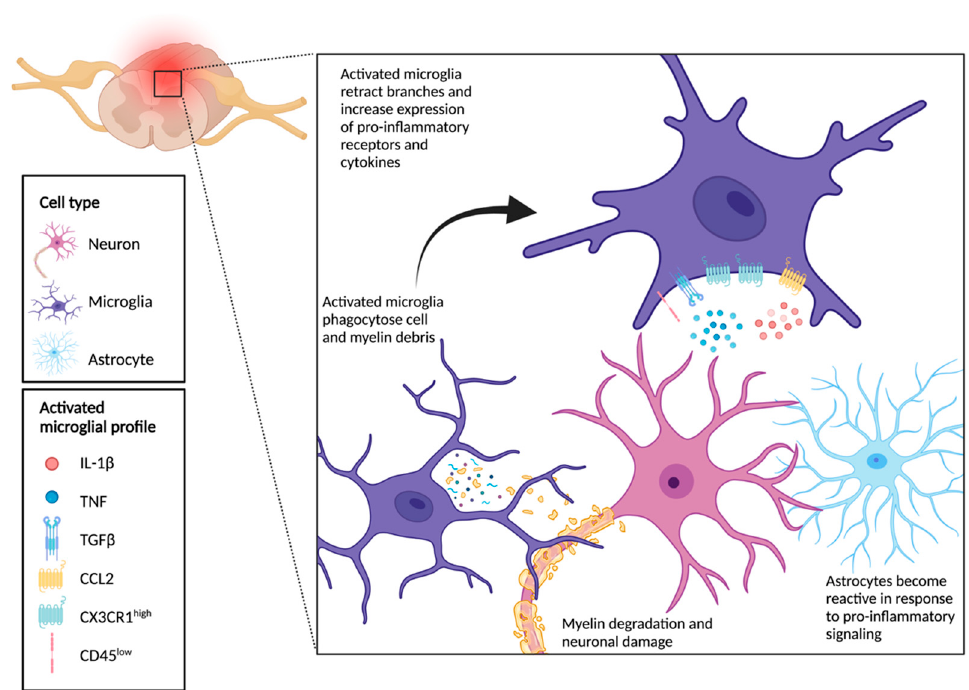
Figure 2. Microglial functional profile in neuroinflammation.